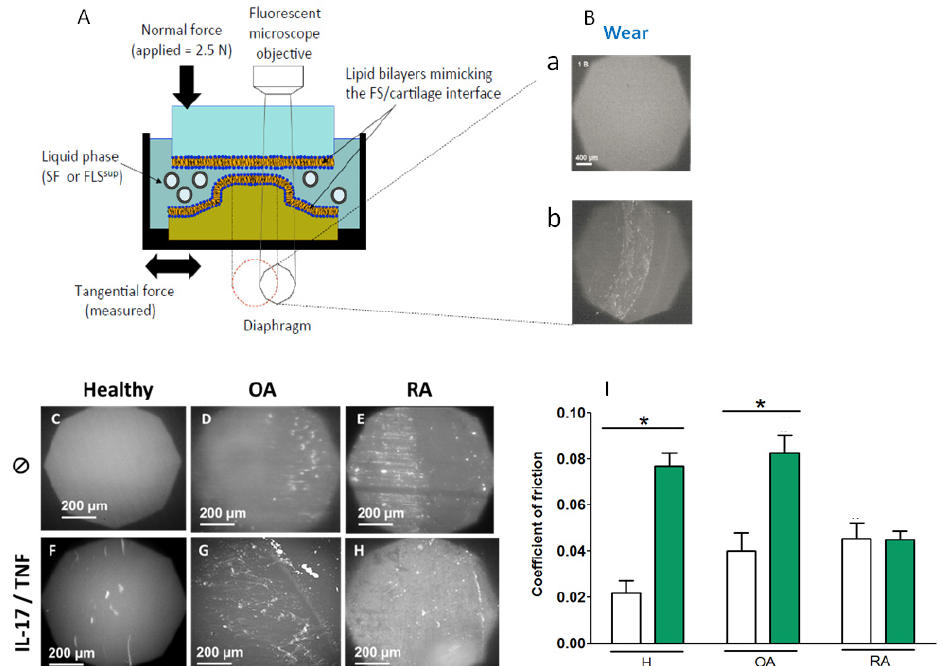
Figure 4. Tribological behavior of vesicle supernatant (H, OA, and RA) after wear and friction tests. ( A ) The principle of functioning of the bio-tribometer apparatus showing the ex vivo contact model. ( B ) Wear: micrographs showing the wear of the lipid interfaces deposited at on the surfaces in contact using white light microscopy ( a ) unworn interface, an even image in the viewing octagon of the microscope ( b ) interface degradations, lighter clusters in the viewing octagon of the microscope. ( C – H ) Micrographs of the lipid interfaces wear for vesicle supernatant (H, OA, and RA) on absence and presence of inflammatory environment. ( I ) Coefficient of friction as a function of pathologies in the absence (white bars) or presence (green) of inflammatory environment (IL-17: 50 ng/mL, TNF- α : 1 ng/mL). Error bars represent SD values calculated on at least 3 independent measurements. * p < 0.01.